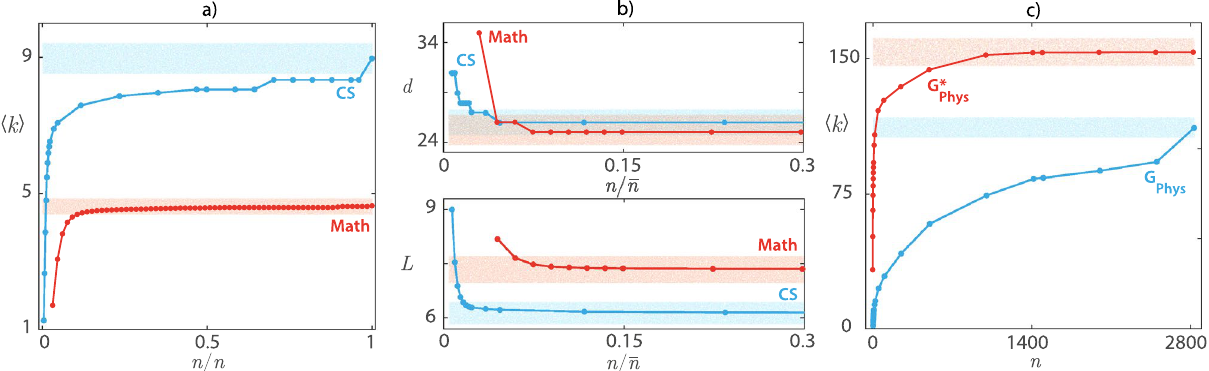
Figure 3. Illustration of the maturation process of different topological features. Panel (a) : the average degree (cid:31) k (cid:30) vs. the normalized fusion index n / ¯ n (see text for definitions), for the areas of mathematics (light red curve) and computer science (light blue curve). The horizontal light red and light blue bars stand for the (plus or minus) ε = 0.05 errors around the respective asymptotic values � k � ( ¯ n ) . Panel (b) : the upper (lower) sub-panel reports the evolution of the diameter d (of the shortest path L ) in the areas of mathematics (light red curve) and computer science (light blue curve). d maturates at layer 3 in the area of mathematics and at layer 10 in the area of computer science; L instead maturates at layer 4 in mathematics and again at layer 8 in computer science. Notice that different topological features maturate at different fusion stages. Panel (c) : the average degree (cid:31) k (cid:30) in the area of physics vs. the fusion index n , for the direct graph G phys (light blue line) and for the dual graph G ∗ phys (light red